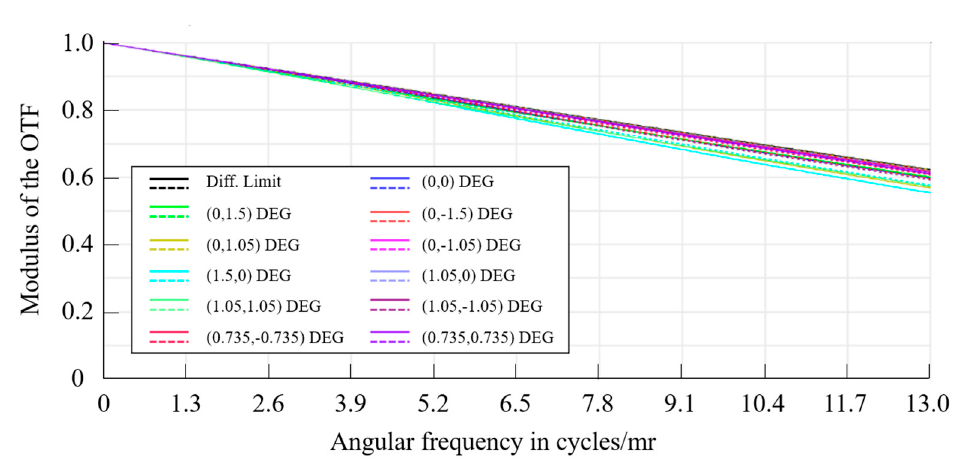
Figure 15. Final structure MTF of the off-axis four-mirror system.